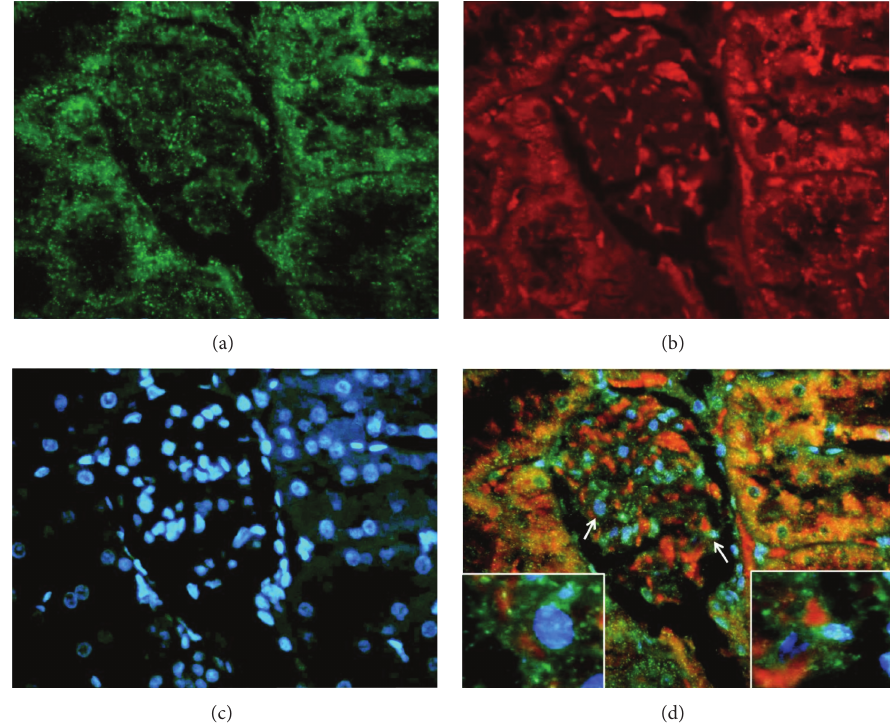
Figure 8: Double fluorescence assay in an animal treated with CuSO 4 showing (a) a glomerulus stained in green by FITC-annexin localized to the apoptotic membranes, (b) La ribonucleoprotein stained by Texas red, (c) glomerulus nuclei stained in blue by DAPI, (d) merging image which shows colocalization of La/annexin; the arrows are representative examples of fields analyzed for colocalization of annexin (green) and La ribonucleoprotein (red) onto apoptotic membranes. The squares correspond to magnification areas pointed by arrows.